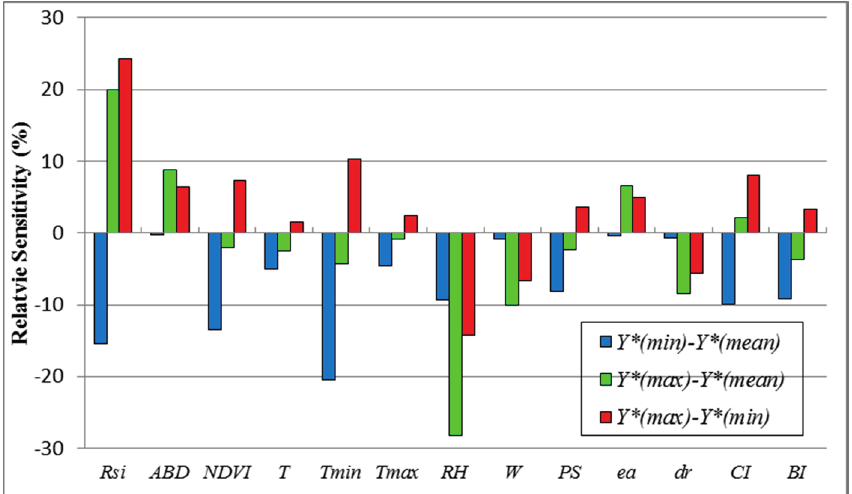
Figure 5. Sensitivity analysis of the variables used to predict R n